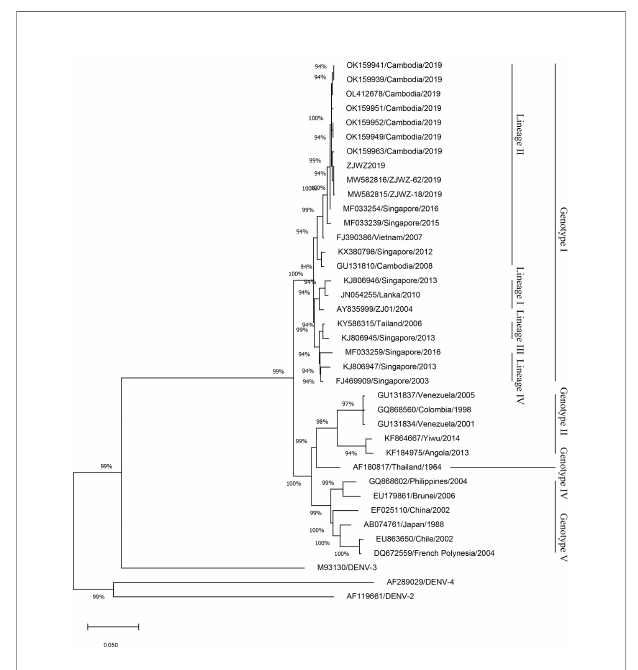
FIGURE 4 | Phylogenetic tree based on the complete genome sequences of DENV-1.